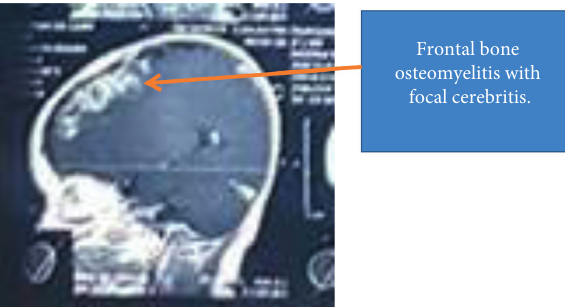
Figure 3: MRI brain of the infant in which left frontal bone os- teomyelitis with focal cerebritis can be seen.